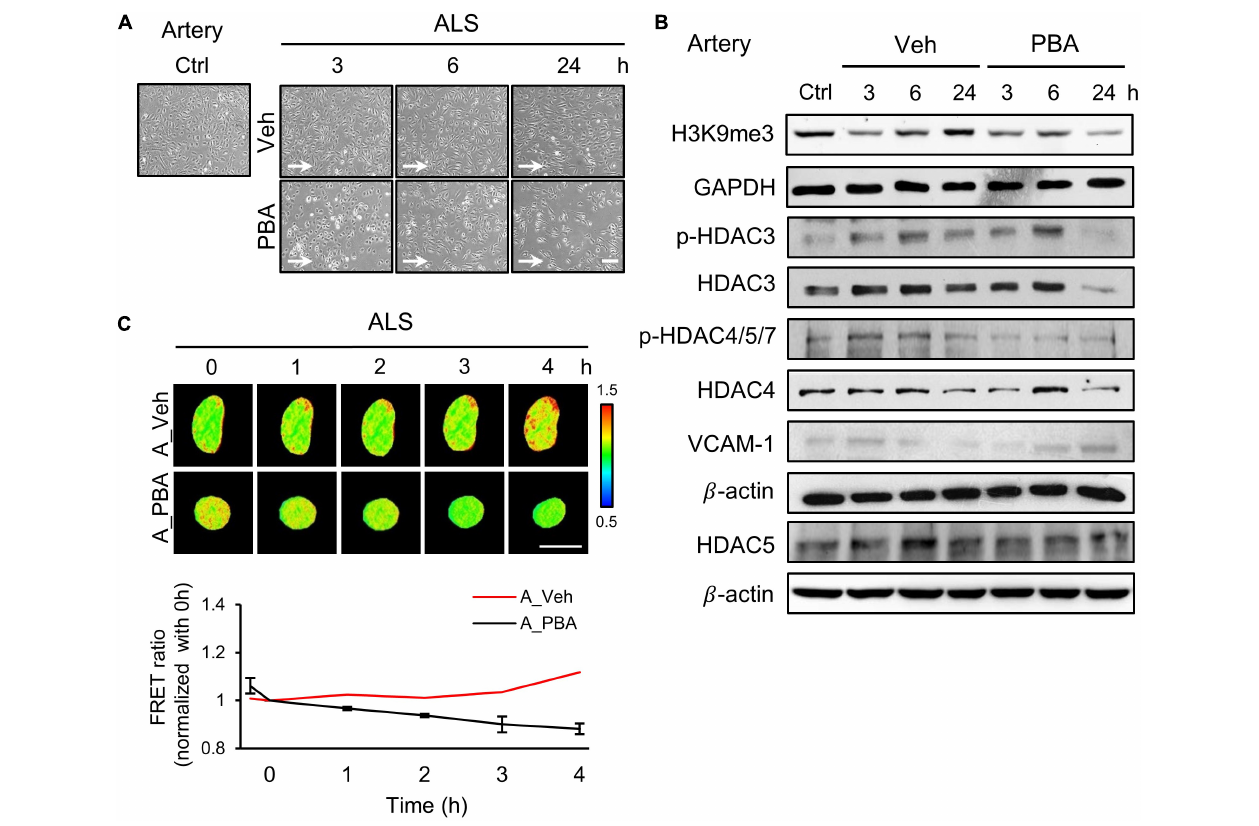
FIGURE 3 | PBA inhibited the expression of H3K9me3 in arterial ECs. (A) The images were presented the cell morphology of PBA (150 µ M) or vehicle-treated arterial ECs (HUVECs) under ALS at 3, 6, and 24 h. PBA-induced arterial ECs had gradually increased the number of round-up damage morphology after subjected to ALS at 3, 6, and 24 h. (B) Protein expressions were examined by using Western blotting analysis. The decreases of H3K9me3, p-HDAC3, p-HDAC4,5,7, HDAC3, HDAC4, and HDAC5 and the increase of VCAM-1 were observed after treating PBA under ALS in HUVECs compared to vehicle group. (C) By utilizing the H3K9me3 FRET biosensor to examine the H3K9me3 status, the FRET ratio of H3K9me3 was declined in PBA-treated HUVECs under ALS condition compared to the vehicle group (C) . Scale bar in (A) = 200 µ m. Scale bar in (C) = 20 µ m. Data were represented as mean ± SEM. Arrow indicated the flow direction of ALS (left to